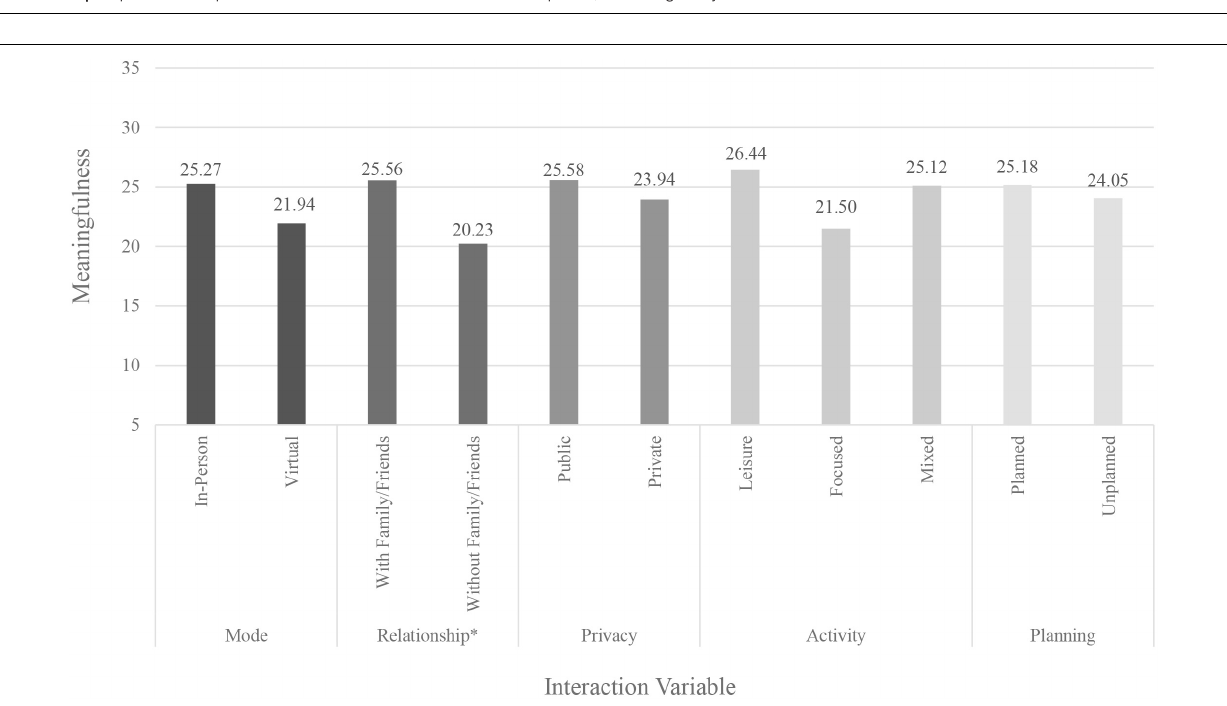
FIGURE 1 | Proportion of in-person interactions in three most common spaces, excluding first year students.